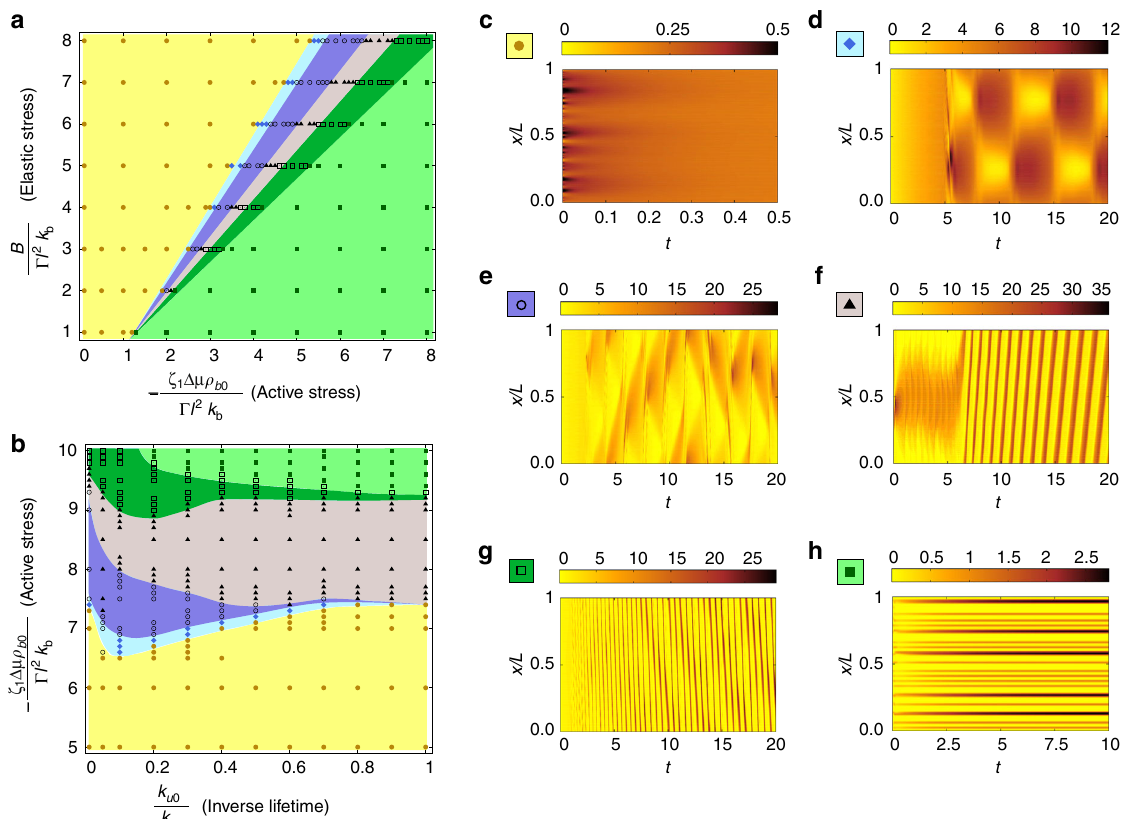
Fig. 2 Phase diagram obtained from numerical solutions of Eqs. 7 and 8. a Effective elastic stress density vs. contractile stress density, with k = 0.1. b Effective contractile stress density vs. inverse-lifetime, with B = 5. The phases are (i) Stable (yellow), (ii) spontaneous Oscillatory (blue), (iii) spontaneous Moving (grey) and (iv) contractile Collapse (light-green). The corresponding kymographs of the bound myosin density (indicated by the color and symbol on the upper right corner) is shown in c , d , f and h , respectively. The regions marked violet and dark-green are the coexistence phases — the oscillatory- moving coexistence (open circle) and the collapse-moving coexistence (open square), with the corresponding kymographs shown in e and g , respectively. Apart from the new phases, the topology of the phase diagrams are roughly similar to the linear stability diagram (Fig. 1b), except for the upturn of the phase boundaries towards larger active stress in b , which arises from the nonlinear strain-dependent unbinding. Symbols are points at which numerical solutions have been obtained. Rest of the dimensionless parameters are, α = 3, c = 0.1, χ ( ρ 0 ) ζ 1 = − 0.5, and ζ 2 = 0.1 (see “ Methods ”